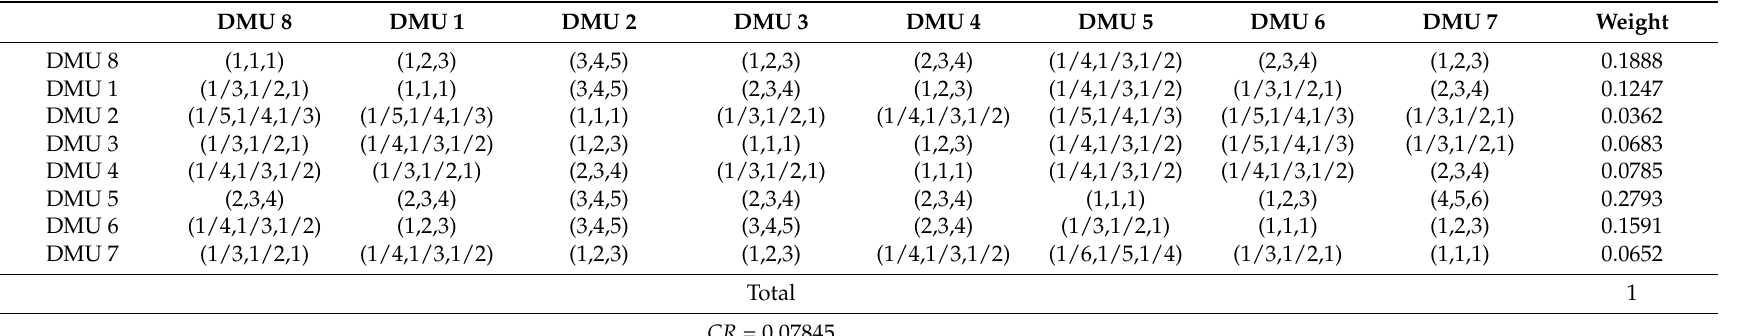
Table A27. Comparison matrix for EQR based on